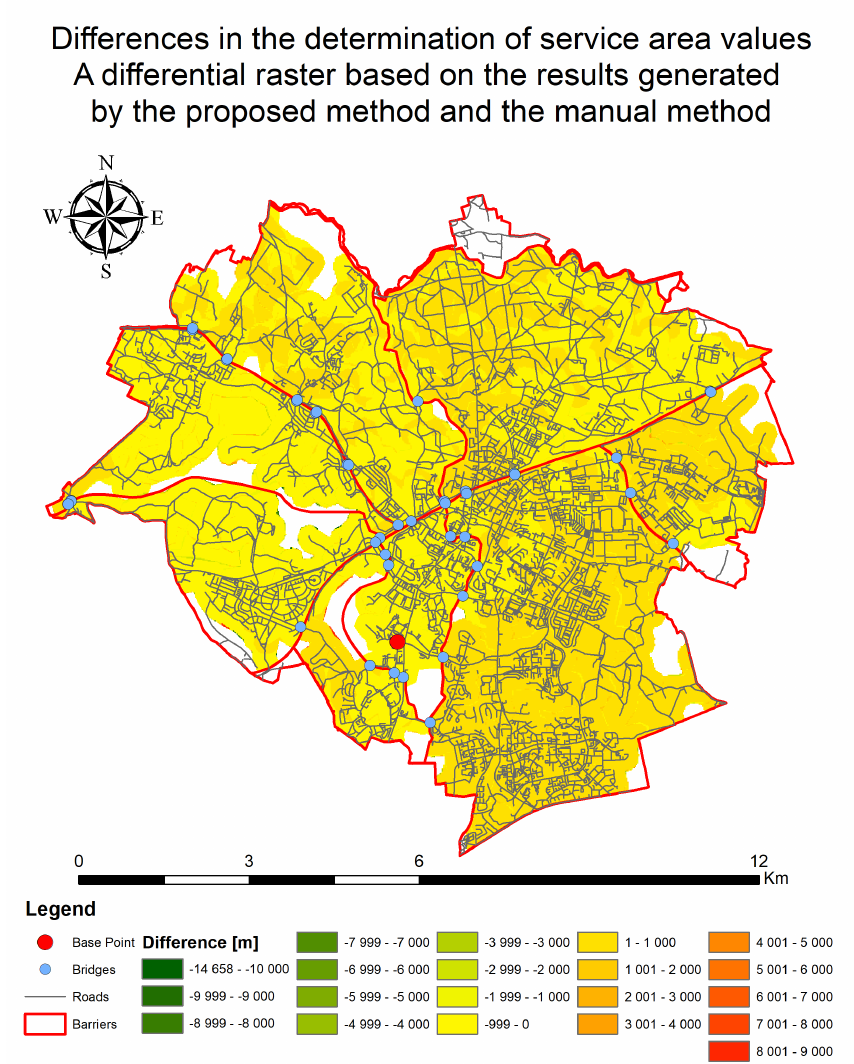
Figure 19. A differential raster of the values of service area polygons generated with the proposed algorithm and the manual method [34] based on Olsztyn